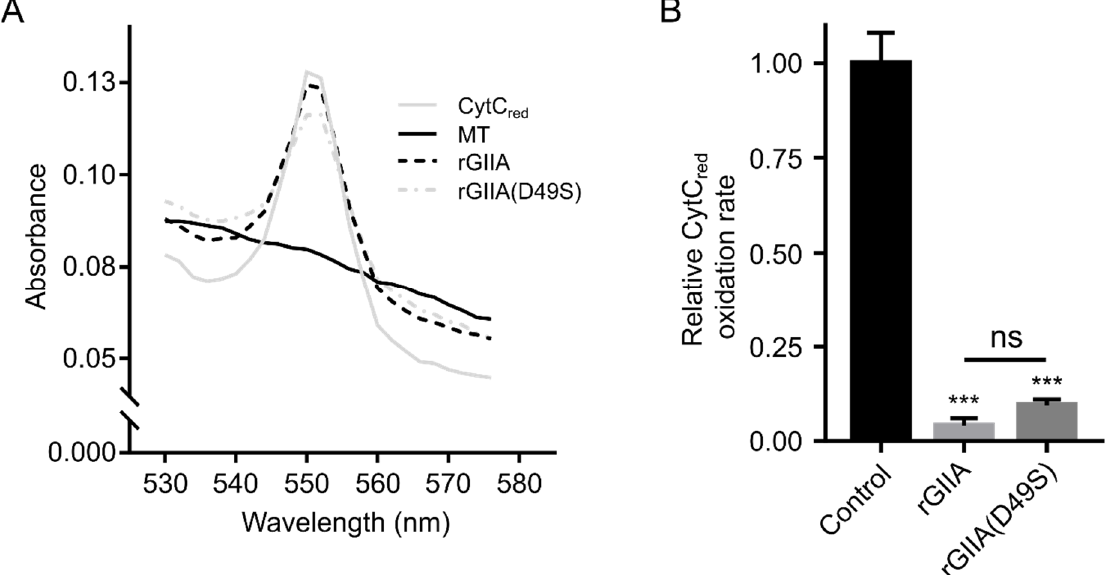
Figure 3. rGIIA or rGIIA(D49S) inhibits the enzyme activity of CCOX in isolated mitochondria. Mitochondria were isolated from PC12 cells and were incubated in either the absence (MT) or the presence of 1 µM rGIIA or 1 µM rGIIA(D49S). After the addition of the reduced cytochrome c (CytC red ), which is a CCOX substrate, the change in absorbance at 550 nm (A 550 ) (where CytC red has maximum absorption) was measured. ( A ) Representative absorbance spectra of the samples measured 10 min after the addition of CytC red in the range 530–576 nm. The inhibition of the CCOX enzymatic activity is indicated by retaining a high A 550 compared with the positive control (MT). In the presence of both rGIIA and rGIIA(D49S), the CCOX activity was significantly inhibited. ( B ) The relative CytC red oxidation rates were calculated as described in the Materials and Methods section. The results are presented as the means ± S.E.M. of at least three independent experiments and the statistical significance is indicated (*** p < 0.0001; and ns p > 0.05; one-way ANOVA with Tukey’s post-hoc test).